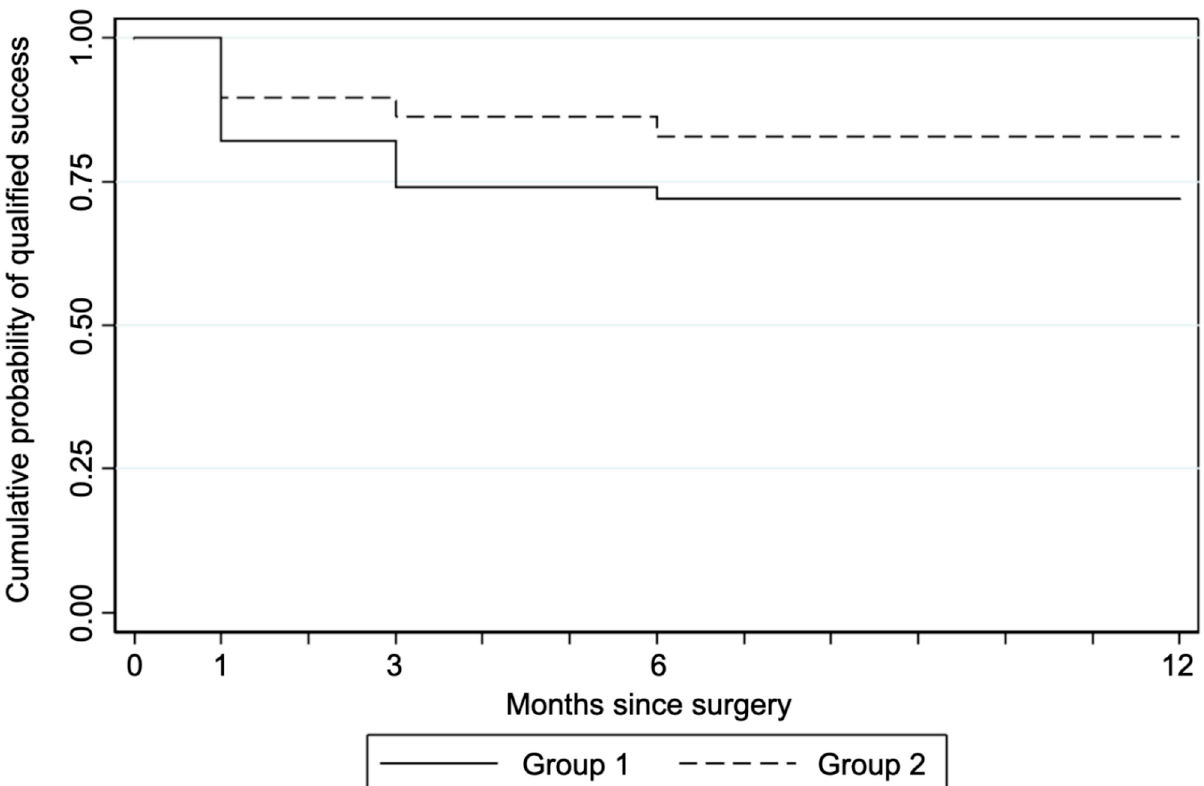
Figure 4. Kaplan–Meier survival estimates for Groups 1 and 2 (failure IOP > 18 mmHg at 3 consecutive follow up visits).